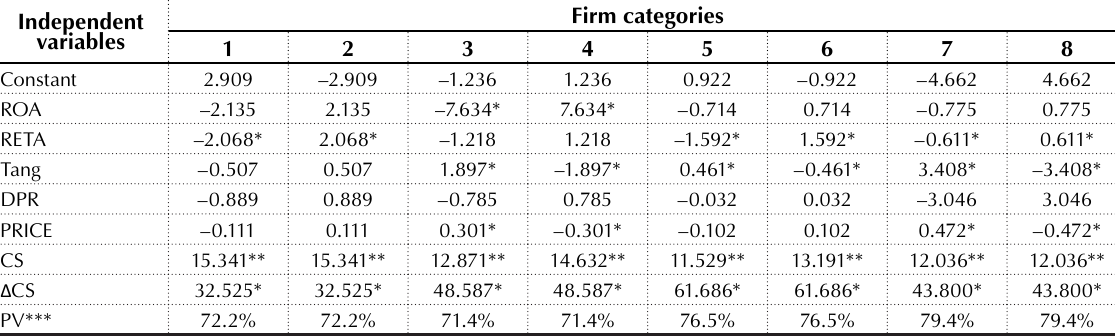
Table 4. Logistic regression results for firm capital structures Independent